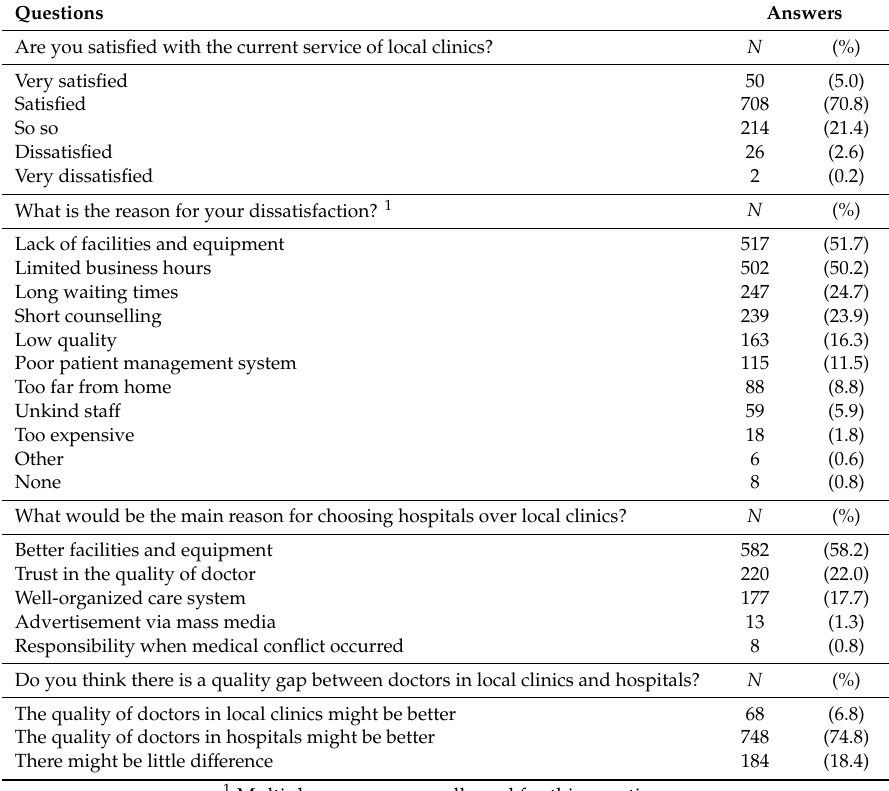
Table 5. General public’s experience and thoughts regarding local